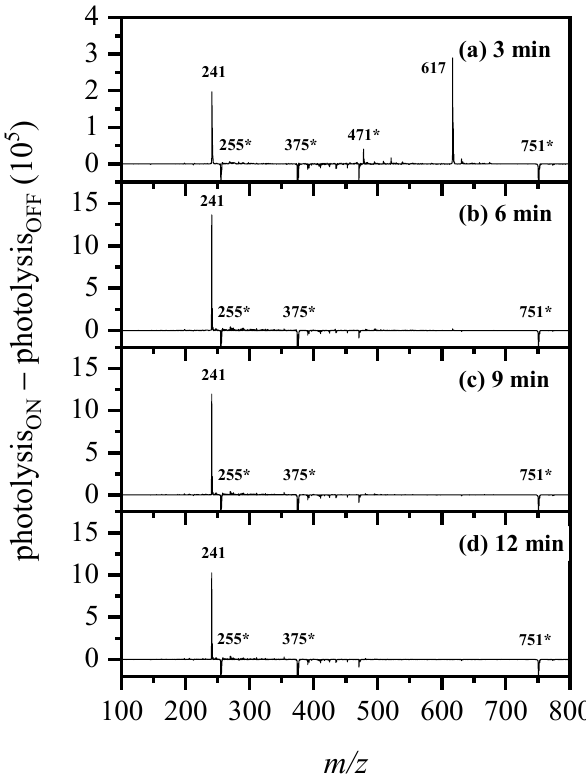
Figure 8. ( a-d ) Photolysis ON —photolysis OFF ESI mass spectra of a mildly alkaline solution of aqueous RF after irradiation at 365 nm (3.4 eV) at 3, 6, 9, and 12 min, respectively. [*] indicates the photodepleted ions at m / z 255, 375, 471, and 751, where m / z 375 is that of the parent ion.